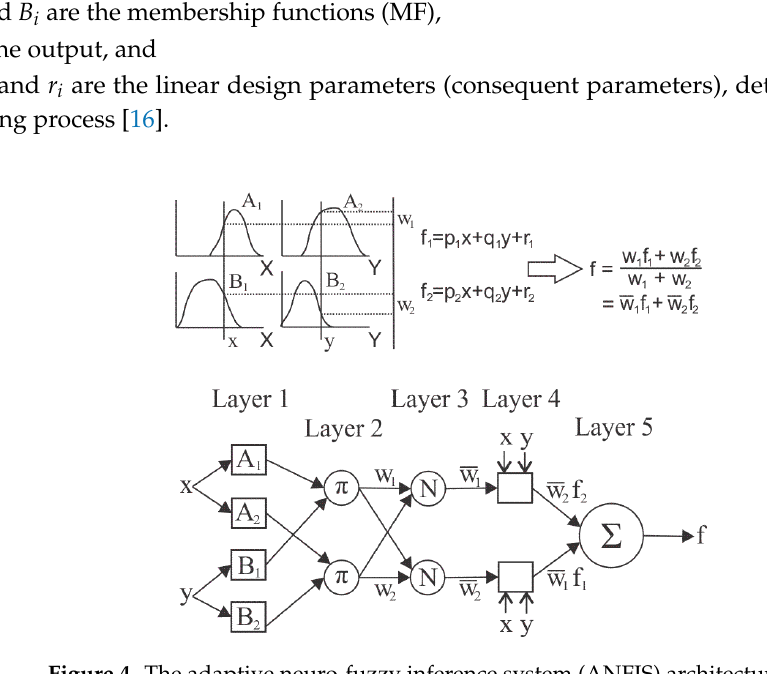
Figure 4. The adaptive neuro-fuzzy inference system (ANFIS) architecture [15].